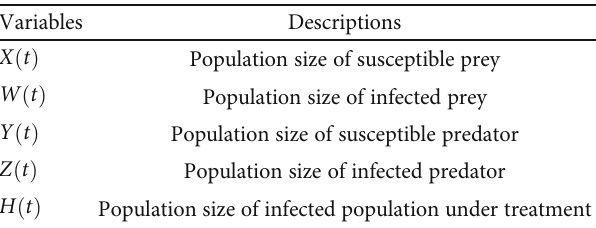
Table 2: Notations and description of